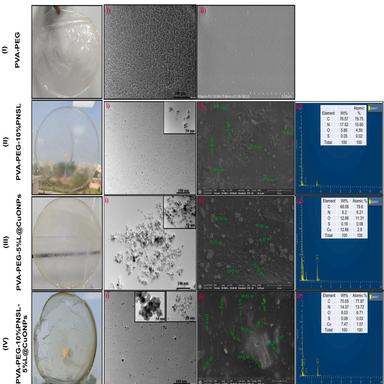
Morphological characterization of nanocomposite films (PVA-PEG, PVA-PEG-10%PNSL, PVA-PEG-5%L@CuONPs, PVA-PEG-10%PNSL-5%L@CuONPs); a-d) Digital images, respectively; I-IV (i) TEM images (scale bar 100 nm; inset scale bar 50 nm, respectively); I-IV (ii) FE-SEM analysis (scale bar 10 μm, 2 μm, and 5 μm, respectively); II-IV (iii) EDS analysis, respectively.